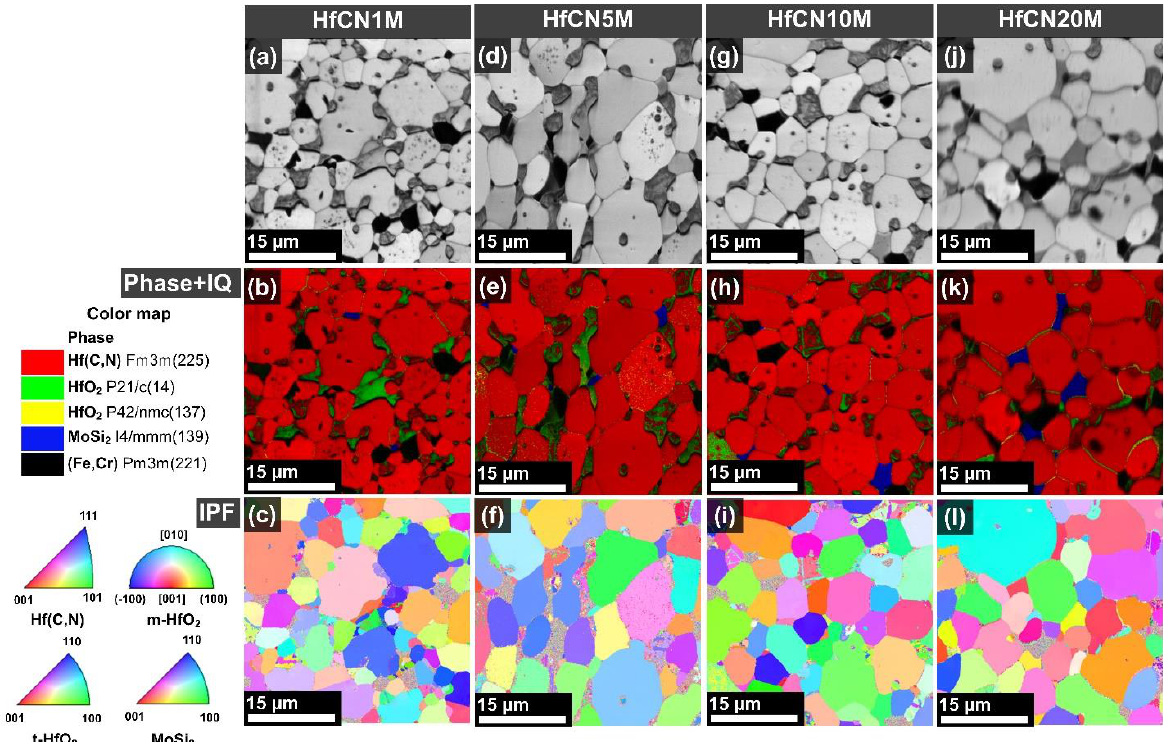
Figure 1. Micrographs and EBSD images of the Hf(C,N)-MoSi 2 samples with different MoSi 2 content: